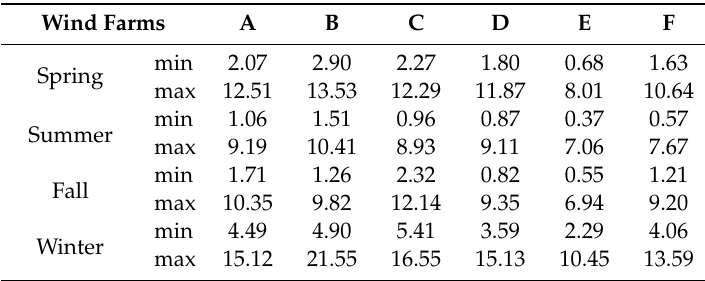
Table 8. Minimum and maximum values of wind power outputs corresponding to 95% confidence interval based on Monte Carlo simulation.